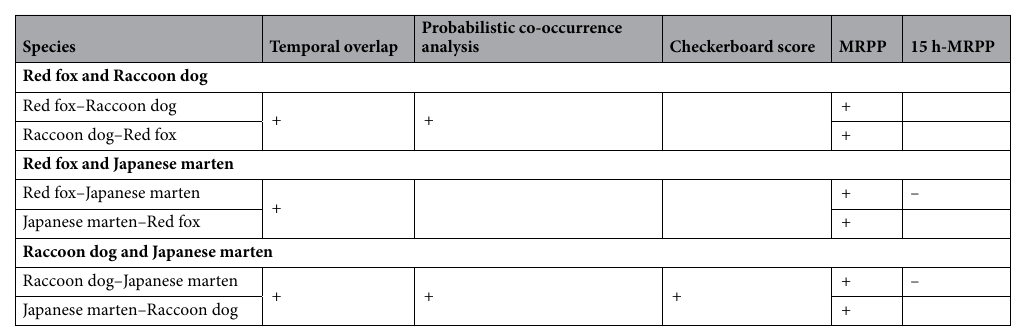
Table 3. Comparison of all analysis results. + represents a result closer to the overlapping side of the temporal niche and – represents a result closer to the partitioning side of the temporal niche.